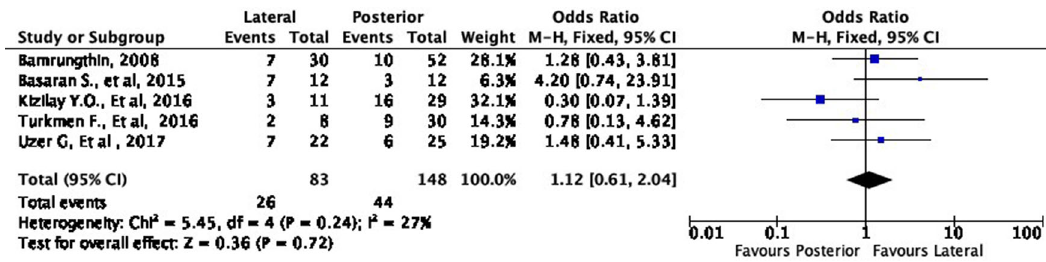
Figure 5. Comparison of functional outcome in the good